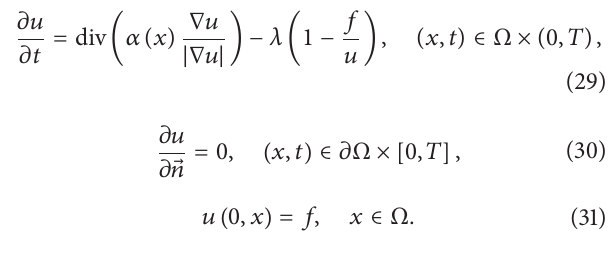
The evolution of the Euler-Lagrange equation for (28)